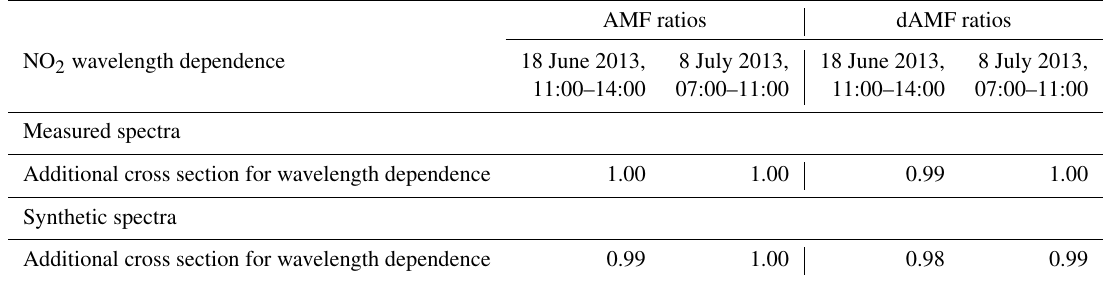
Table A19. Average ratios of O 4 (d)AMFs derived for the analysis with a second NO 2 cross section (cross section times wavelength) vs. those for the standard analysis (only one NO 2 cross section) for the middle period on each selected day (top: results for spectra measured by the MPIC instrument; bottom: results for synthetic spectra when taking into account the temperature dependence of the O 4 cross